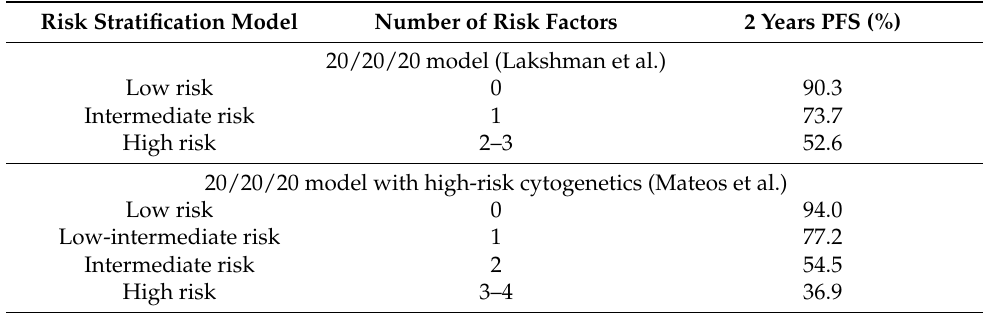
Table 1. Progression-free survival (PFS) at 2 years for SMM patients when stratified according to the 20/20/20 model with and without high-risk cytogenetic abnormalities. Risk Stratification Model Number of Risk Factors 2 Years PFS (%) 20/20/20 model (Lakshman et